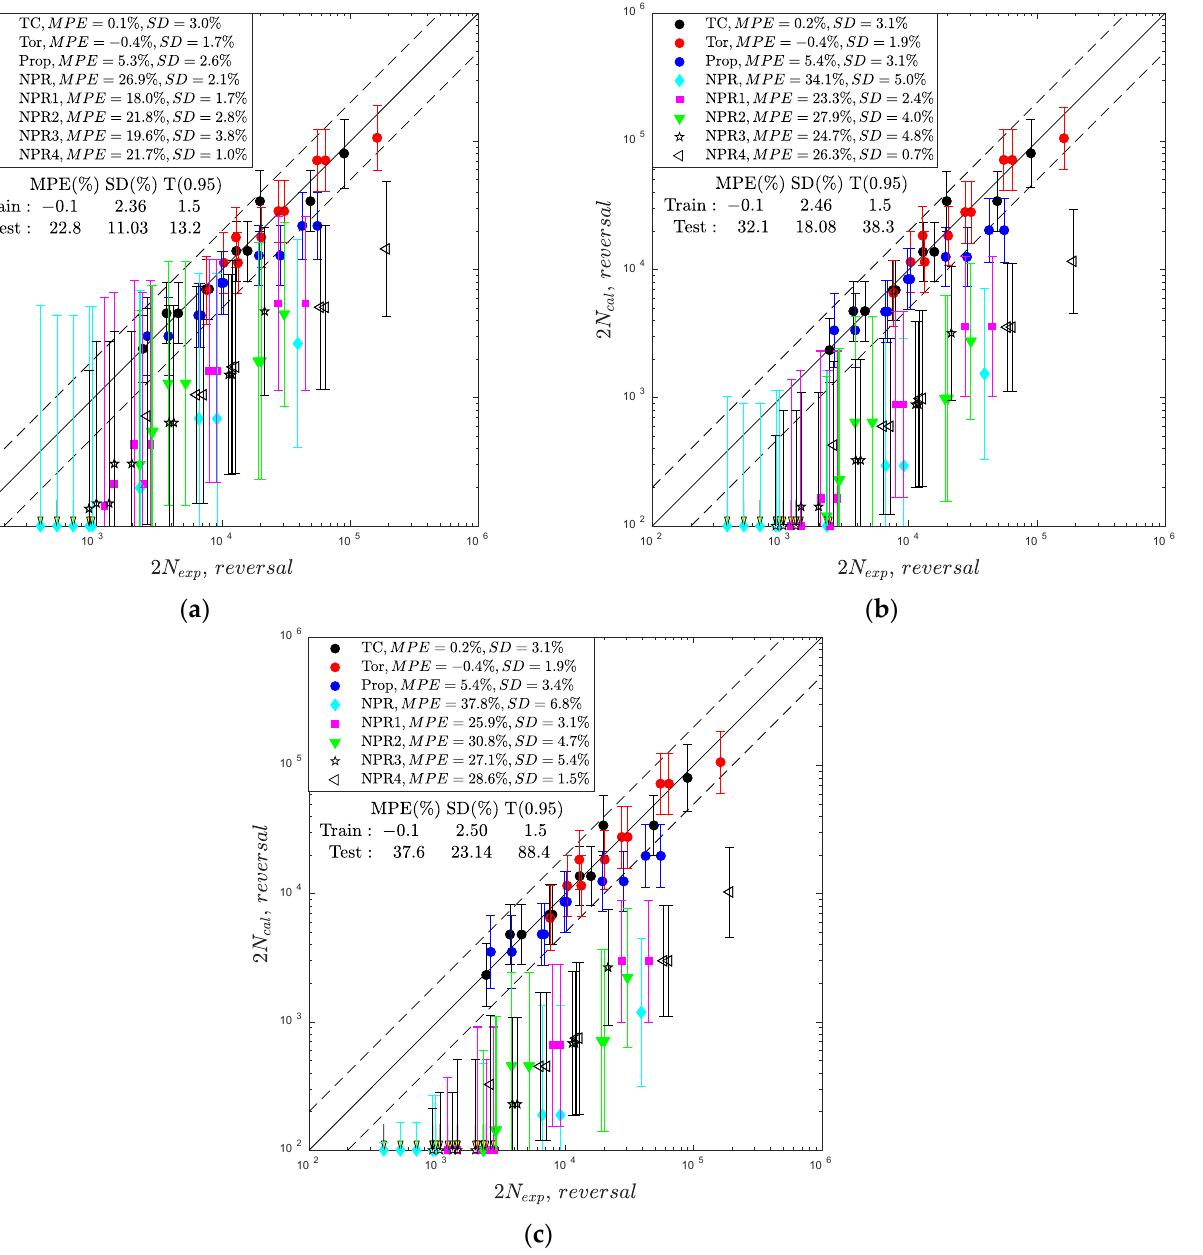
Figure 6. Comparison of experimental and calculated fatigue lives for the fatigue GP-based model for the first training dataset and the following covariance functions: ( a ) Matern 3/2, ( b ) Matern 5/2, ( c ) RQ/SE.